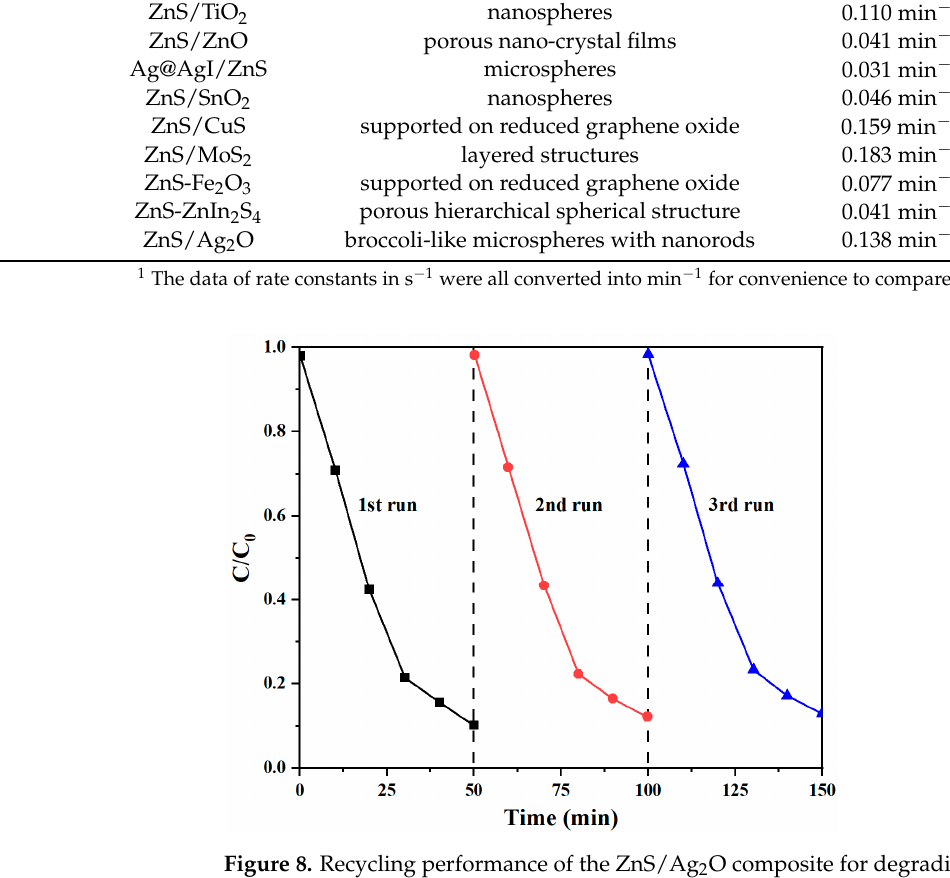
Figure 8. Recycling performance of the ZnS/Ag 2 O composite for degrading MB.